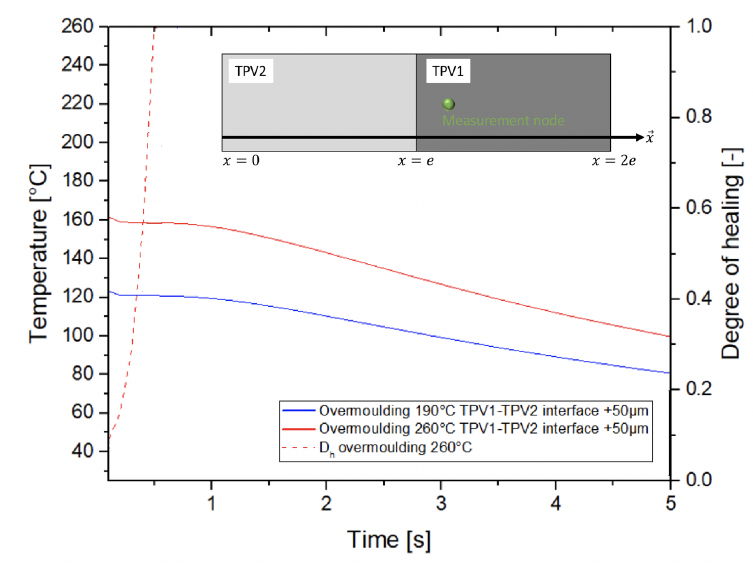
Figure 25. Temperature evolution for a node located at x = e + 50 µ m from interface in